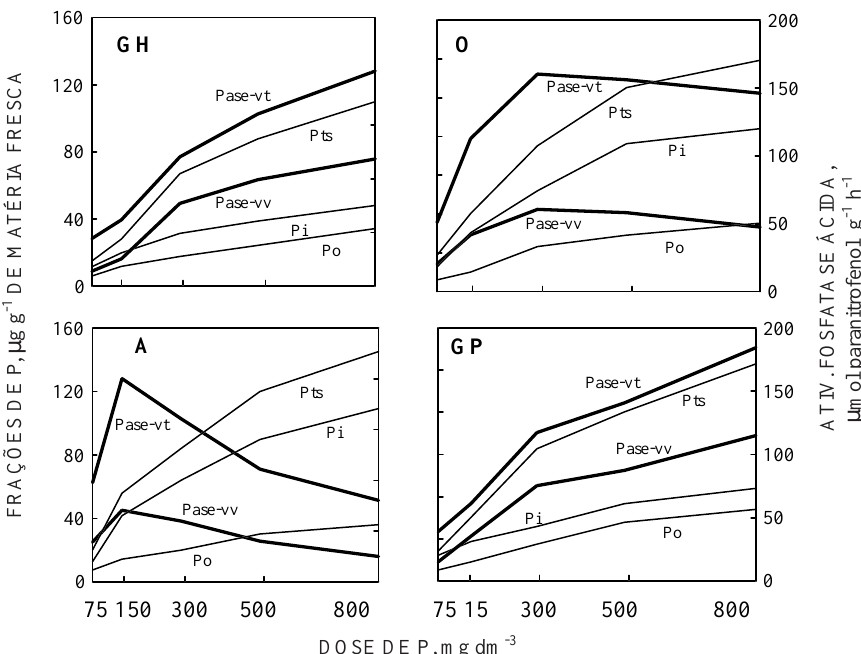
Figura 1. Fósforo total solúvel em ácido (Pts), P orgânico (Po), P inorgânico (Pi) e atividade de fosfatase ácida in vivo (Pase-vv) e in vitro (Pase-vt) nas folhas de feijoeiro cultivado nos solos Glei Húmico (GH), Orgânico, Aluvial (A) e Glei Pouco Húmico (GP), na ausência de calagem.